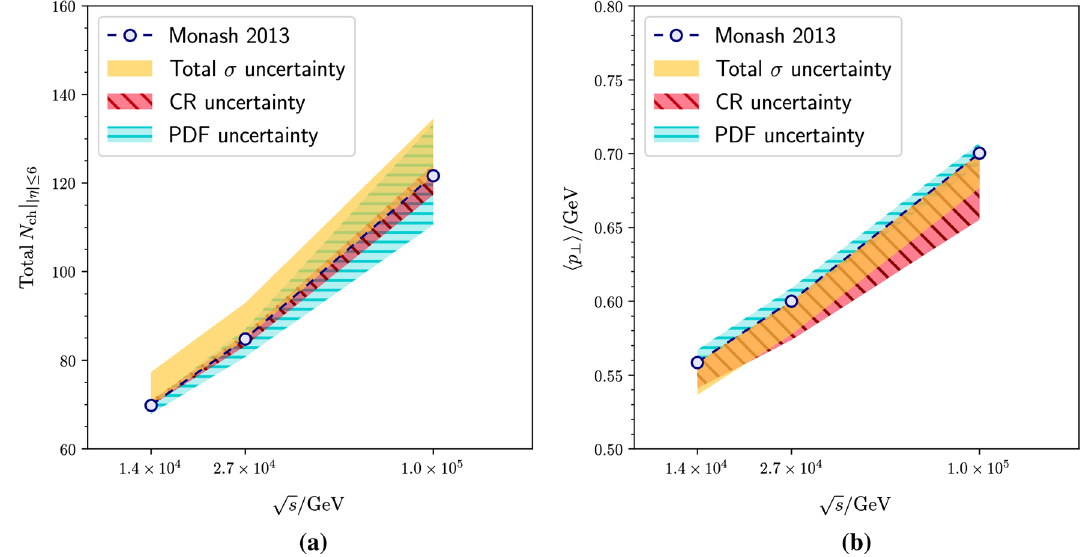
Fig. 6 Energy scaling of a the total number of charged tracks inside | η | = 6, and b the average transverse momentum of charged